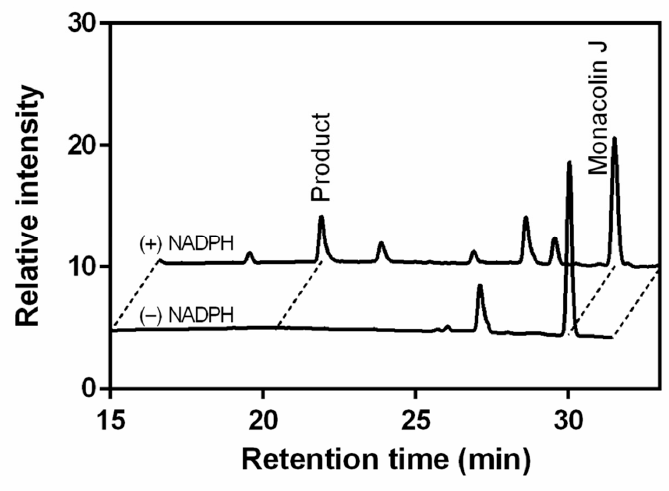
Figure 7. HPLC chromatograms of monacolin J and its products when using HLMs. The reaction mixtures contained 0.4 μ M HLMs and 0.2 mM monacolin J with or without an NADPH regenerating system. The major product and monacolin J appeared at 20.4 and 30.2 min, respectively.